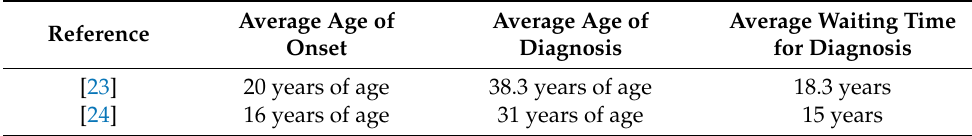
Table 5. Average time between first symptoms and diagnosis of